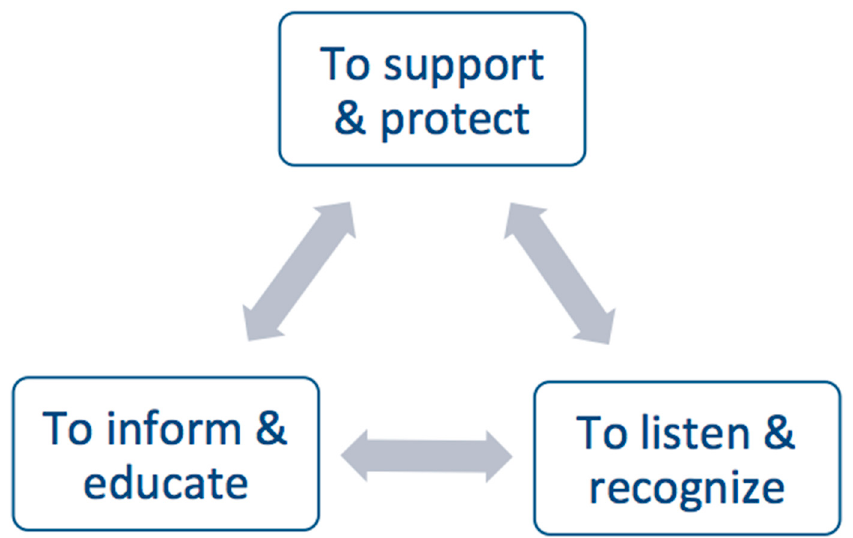
Figure 1. Strategies to preserve the well-being of frontline nursing workforce and their families.